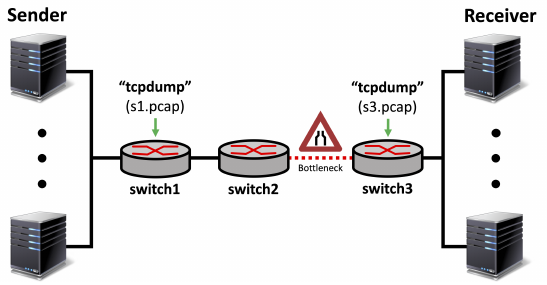
Figure 7. Mininet experimental